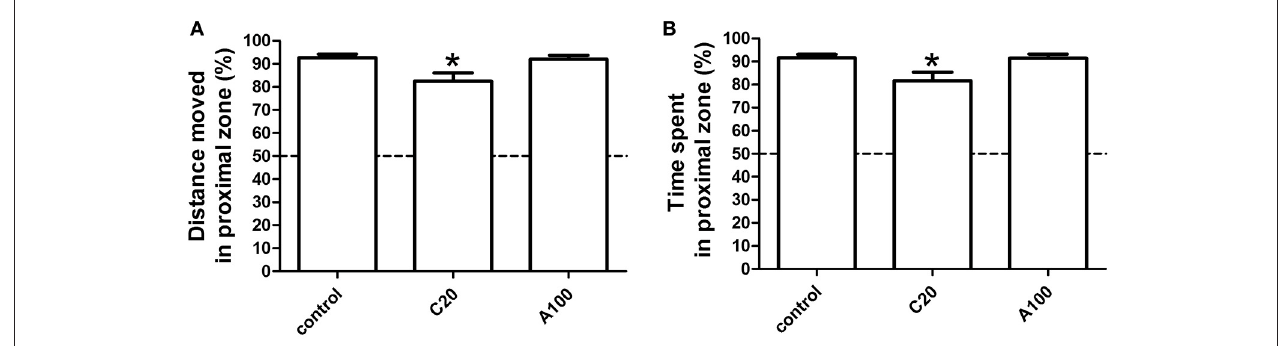
FIGURE 3 | Effects of chronic or acute exposure to VPA on social preference of zebrafish at 1 month of age. The percentage of distance moved in the proximal zone during the first 10-min light phase was plotted in (A) and the percentage of time spent in the proximal zone during the first 10-min light phase (B) was plotted in (B) . The data are presented as the mean ± SEM, n = 32 animals per group. Statistical markers: * p < 0.05; significantly different from the controls.